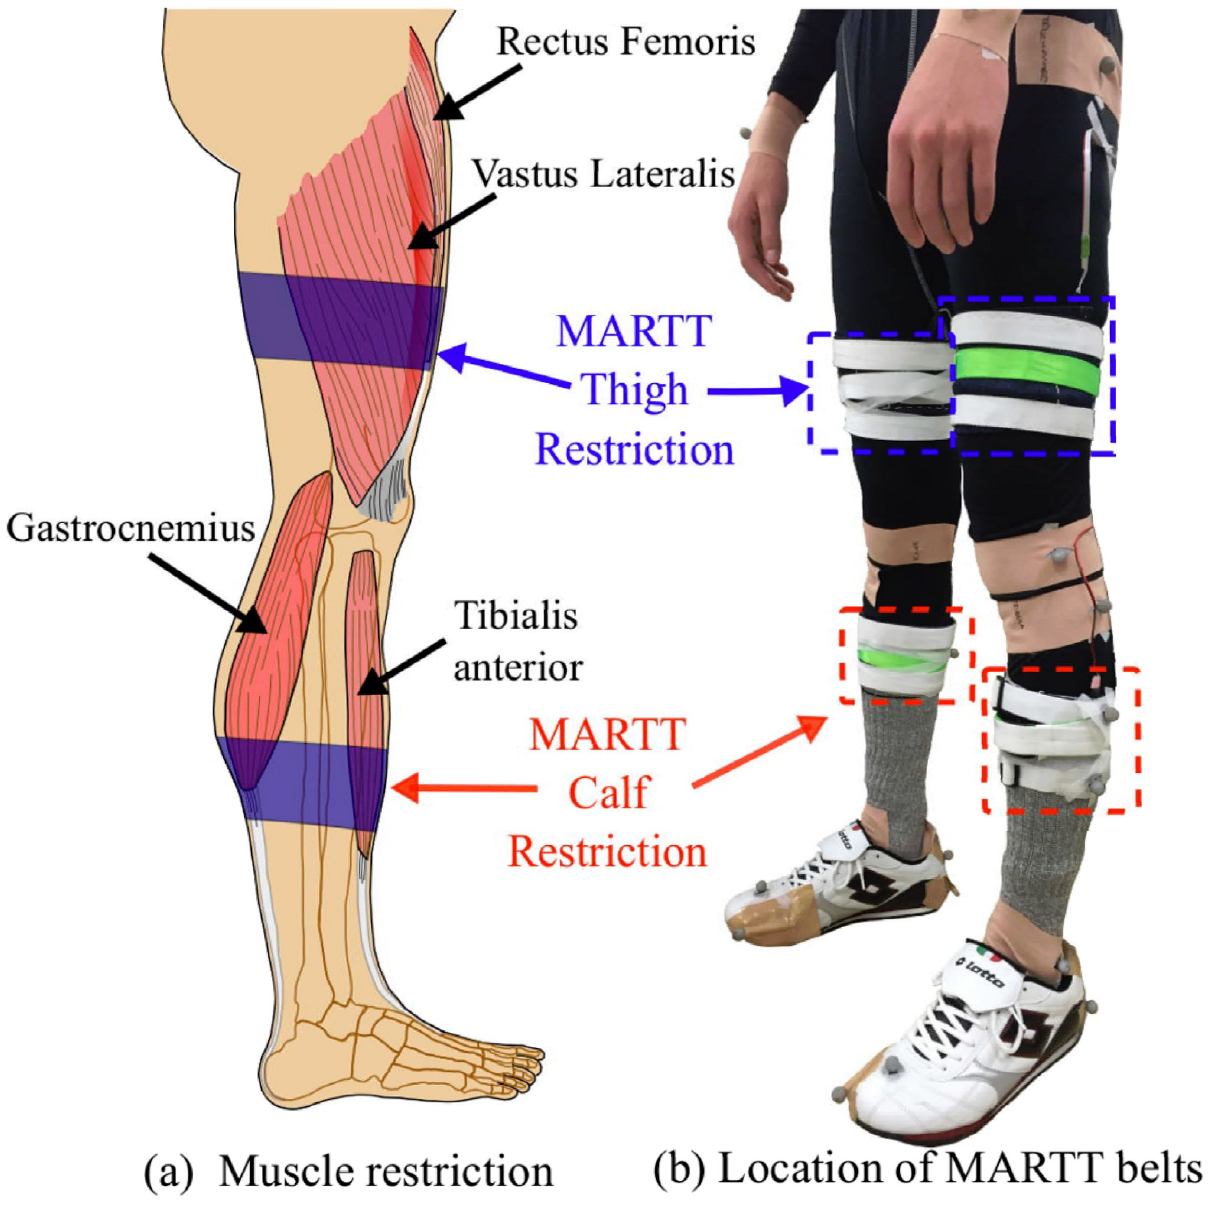
Fig 1. MARTT apparatus. (a) Muscles at the shank and thigh that MARTT target to restrict and (b) Position of the belts used in MARTT to restrict the transversal area of the muscle belly during contraction.